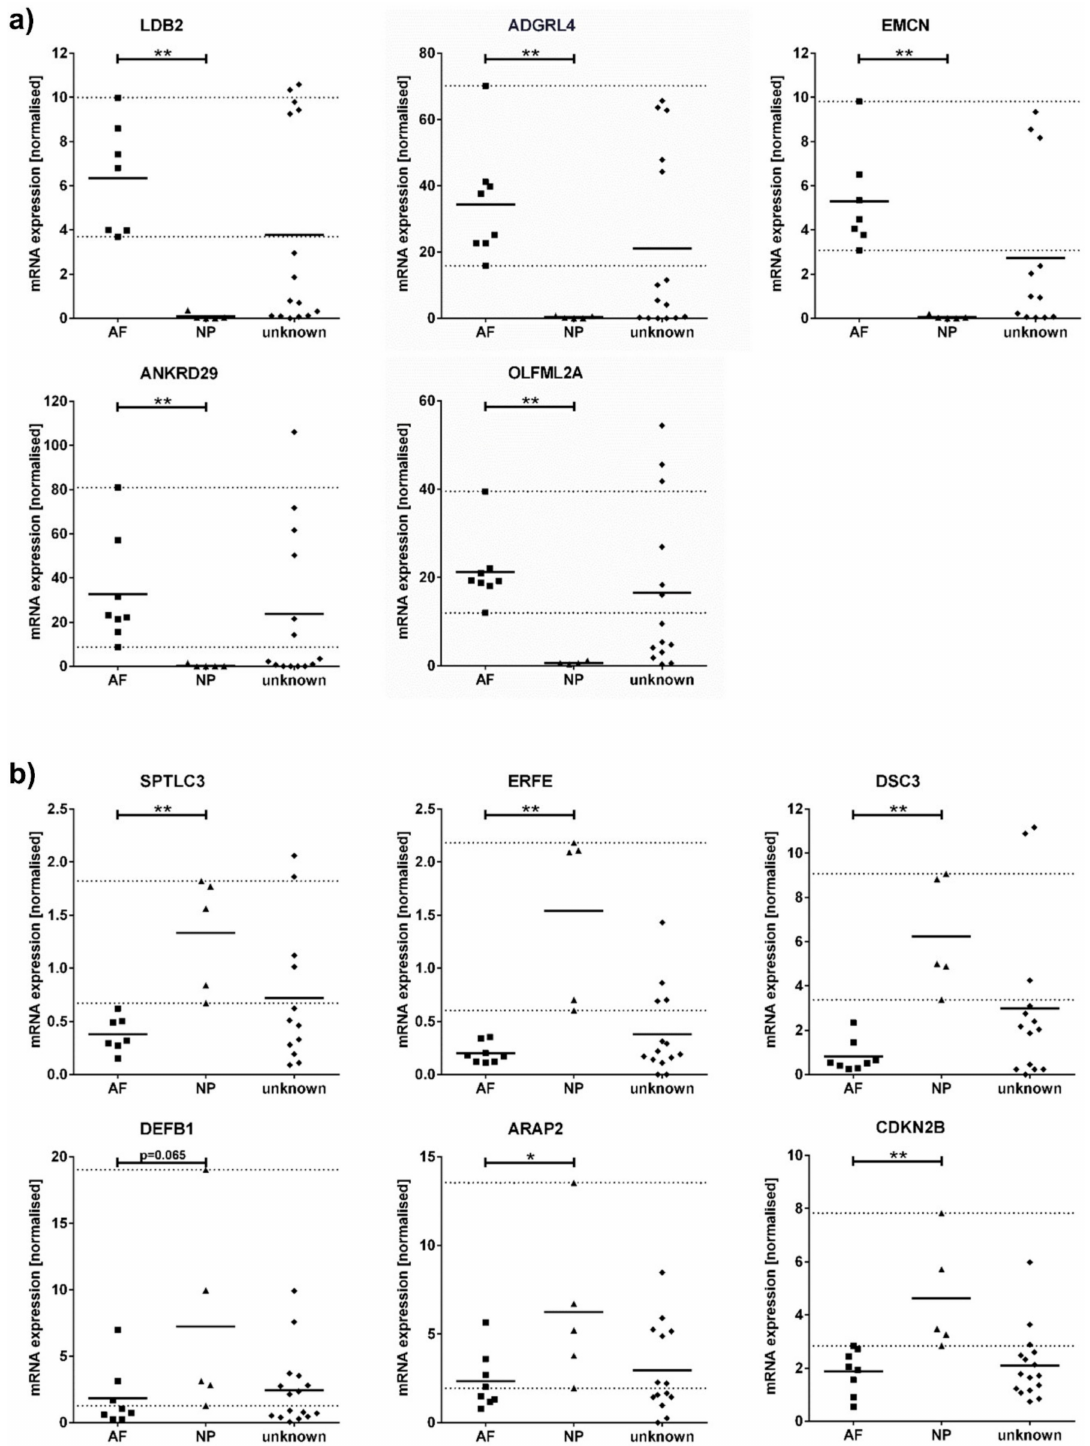
Figure 4. Quantitative gene expression analysis of ( a ) AF and ( b ) NP markers in samples with clear characteristics of AF (squares, n = 9) or NP (triangles, n = 5), and in samples with unknown tissue characteristics (diamonds, n = 16, 1:1 original resection site AF or NP) according to IVD scoring. Results are shown as mean (horizontal bar) with an individual data point for each sample (gene expression level with normalisation to reference genes ATP5F1B and RPL13A). Please note that individual data points are missing as for some samples there was not enough RNA available to perform all measurements. Dashed lines present highest and lowest expression level of each marker in the corresponding tissue (range). Significance * p < 0.05, ** p < 0.01 AF compared to